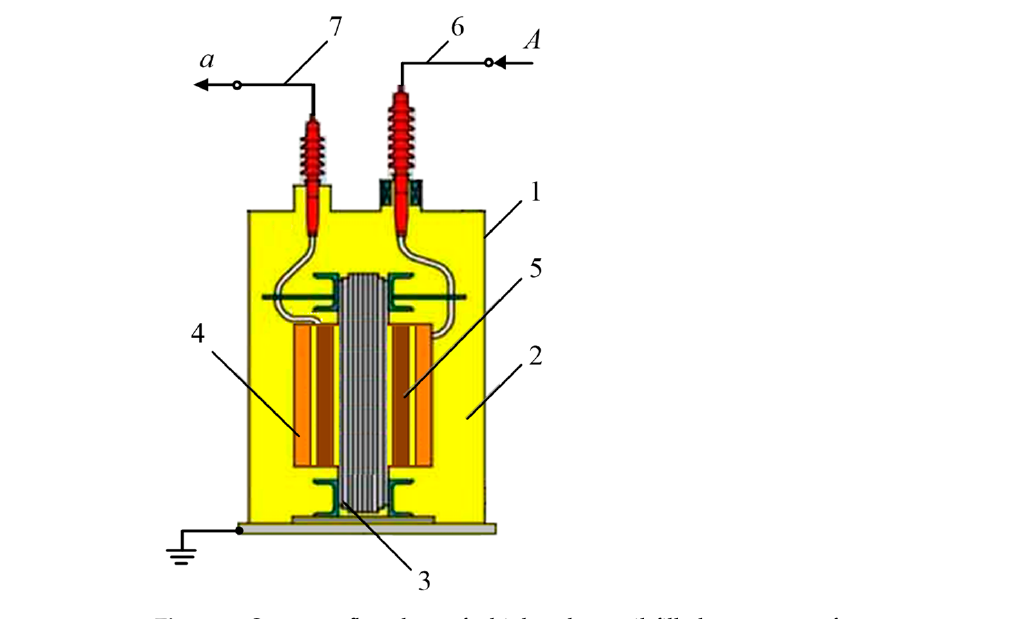
Figure 1. Structure flowchart of a high-voltage oil-filled power transformer.